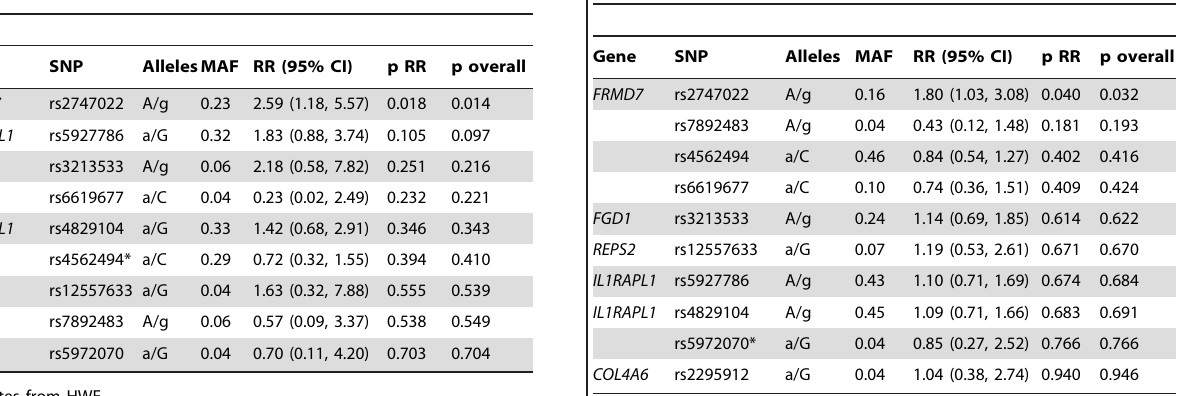
Table 8. Replication of maternal SNPs in the US, Denmark and Argentina